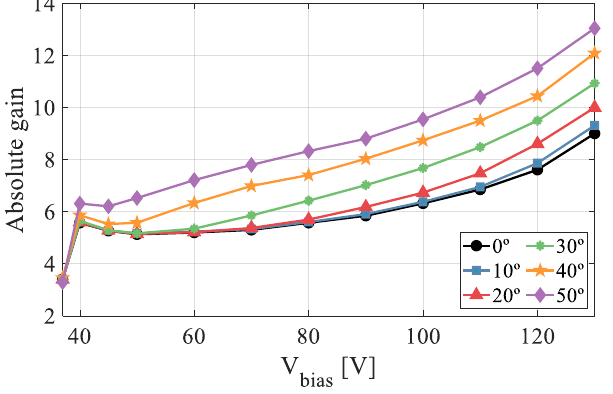
Figure 11. Absolute gain curves for angles of incidence from 0° to 50°.